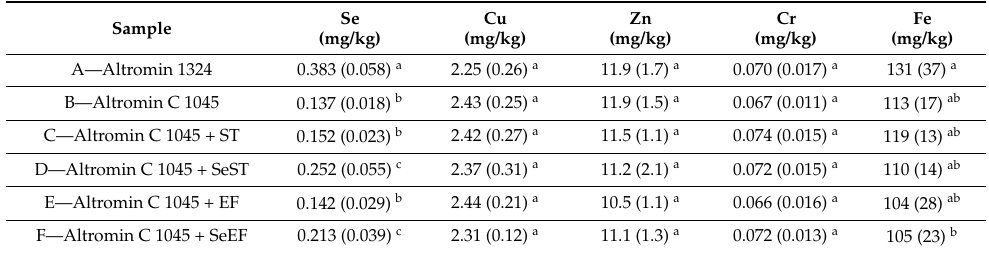
Table 7. Total contents of the elements in rat livers (mg/kg wet weight, n = 8). The averages marked by the same letter do not significantly differ at p < 0.05 within the individual columns; data are presented as the mean (standard